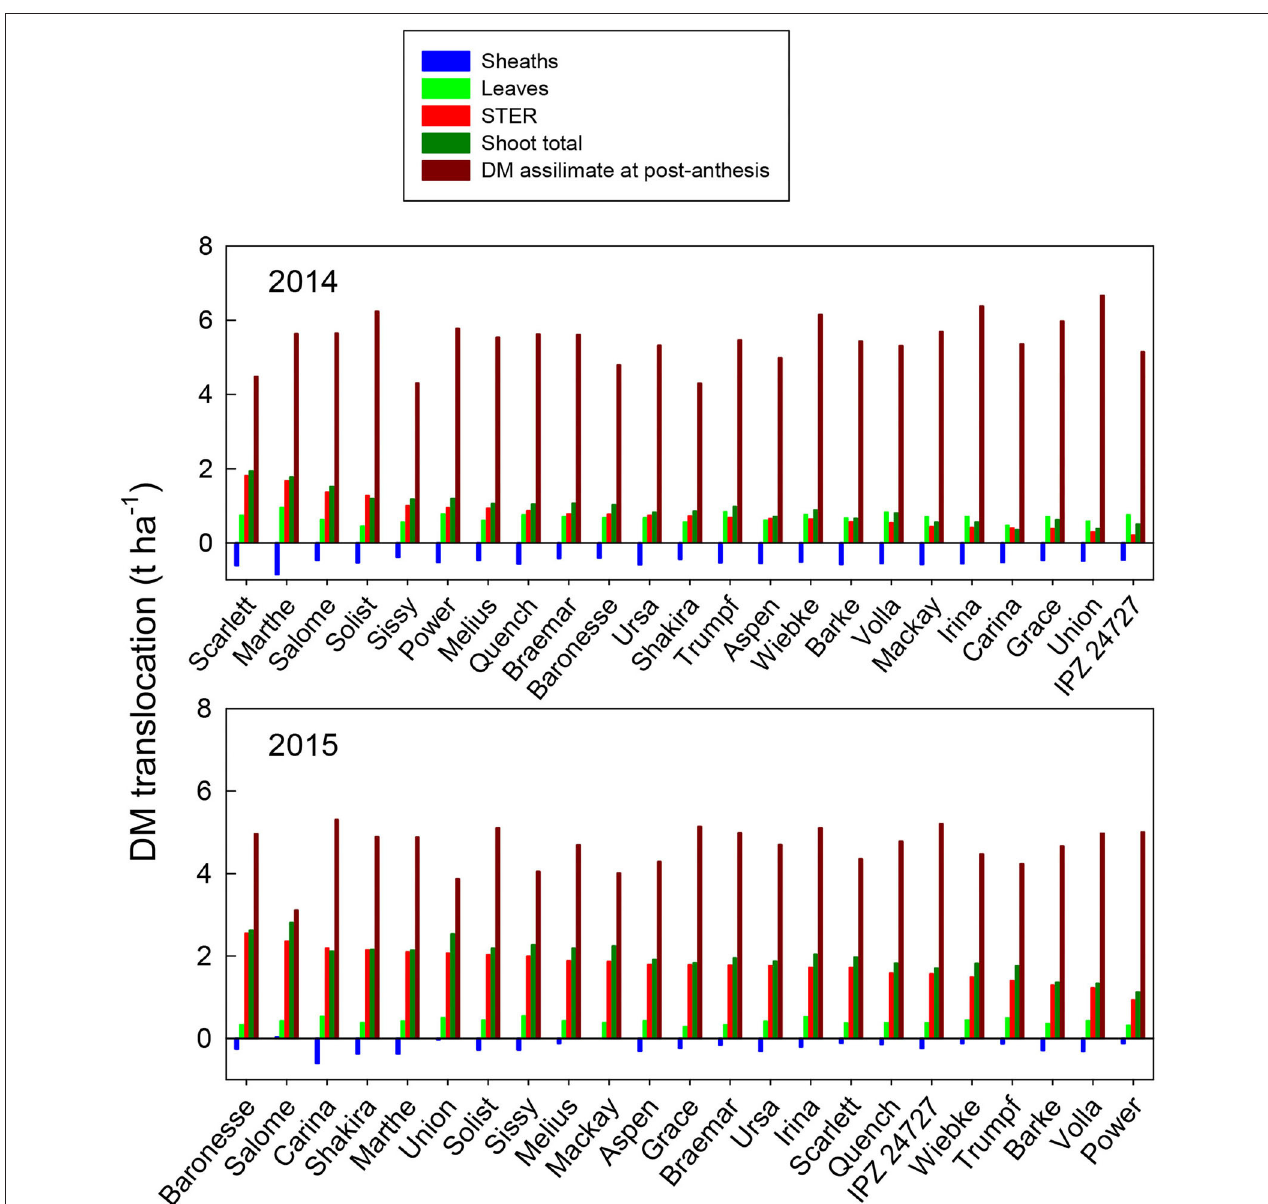
FIGURE 3 | Dry matter translocation from different organs: DM translocation (t ha − 1 ) of different plant organs of the 23 spring malting barley varieties to grain from pre-anthesis and maturity under recommended N fertilization conditions in 2014 and 2015, ranked on DM translocation of STER. Mean comparisons among the varieties from Tukey’s HSD test are shown in Supplementary Tables 2 and 4